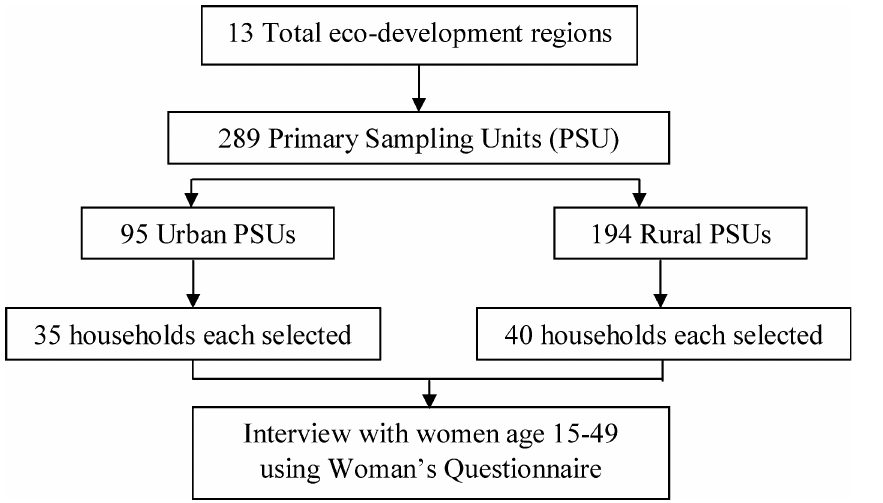
Fig 1. Flowchart depicting selection of mothers